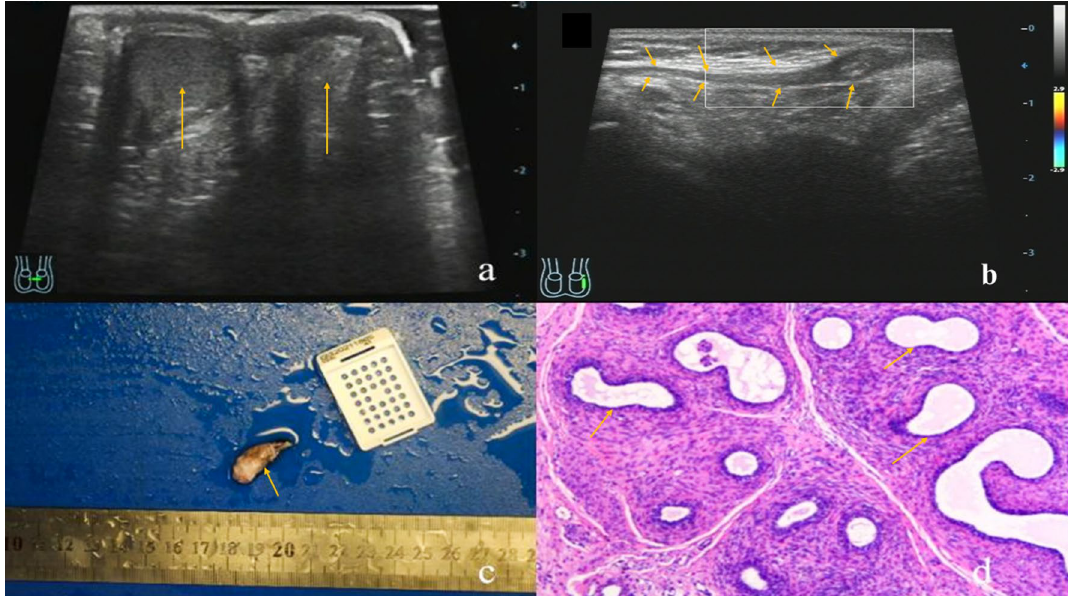
Figure 4. Ultrasound and pathological features of NVT on the left side in a 10-months-old boy. (a) The cross section of the scrotum showed that the right testis was in the right scrotum, and the left testis was not in the left scrotum (b) the long-axis view of the left inguinal canal showed a small hypoechoic nodule at the end of the spermatic cord on the left, with uneven internal echo. CDFI showed no blood flow signal in the nodule (c) the patient underwent resection of the testicular nubbin and the left spermatic cord, and the general pathology of the surgical specimen was gray-white tissue, lacking the shape and structure of the testis, and the size was 2.5 × 1.0 × 0.5 cm (d) under the light microscope, there were displayed fibrovascular, epididymal duct and vas deferens in the specimens, but the seminiferous ducts were not displayed and the pathological diagnosis was testicular regression syndrome